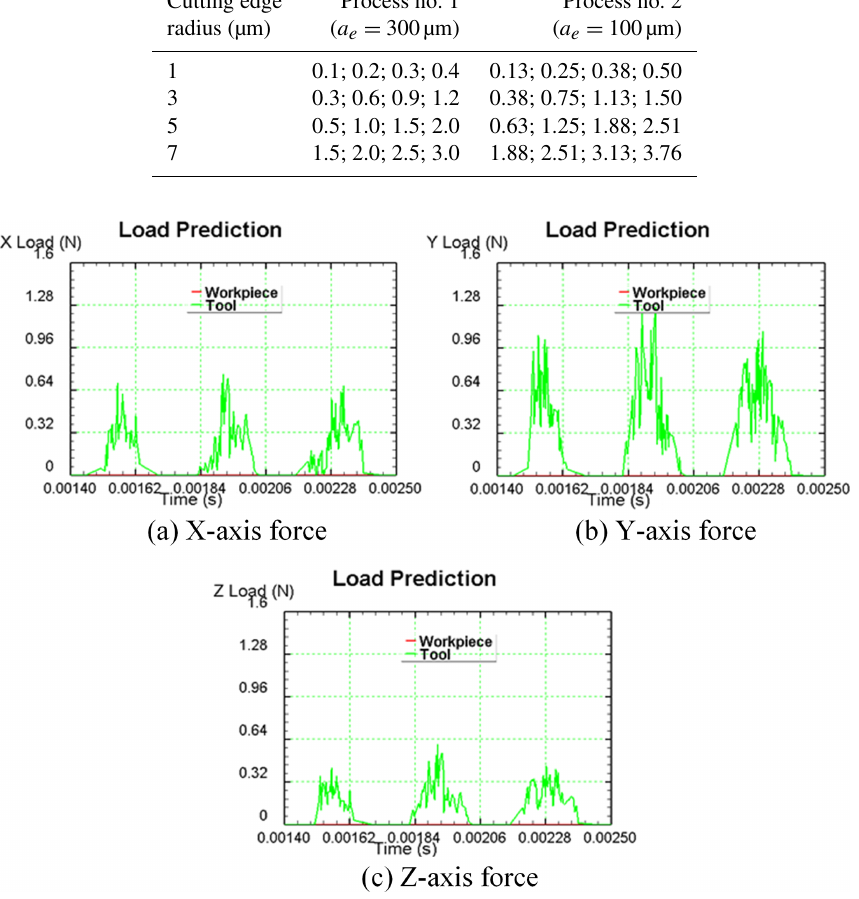
Figure 2. Simulated milling forces of the peripheral cutting edge.